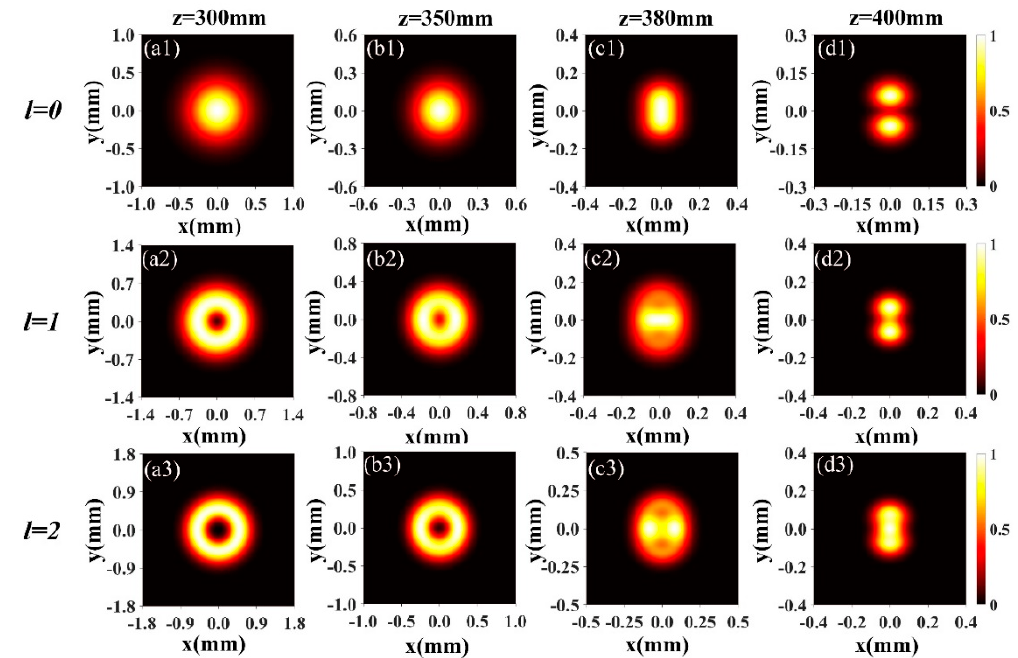
Figure 1. Normalized intensity of a focused HGCSMLG 0l beam at different distances with m = 0, n = 1 and increasing values of the TC.